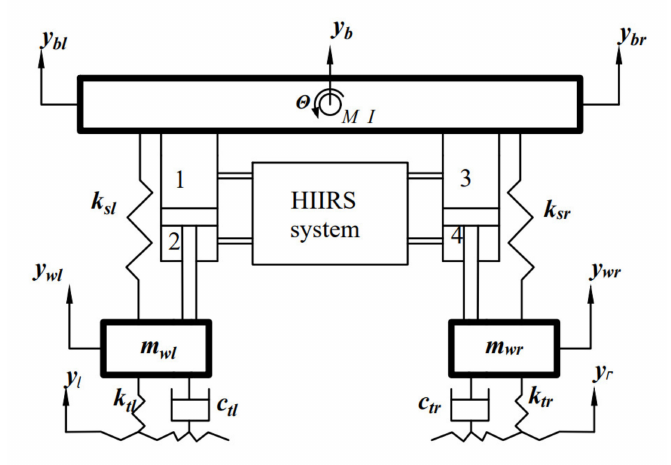
Figure 2. Schematic of a half-car with an HIIRS